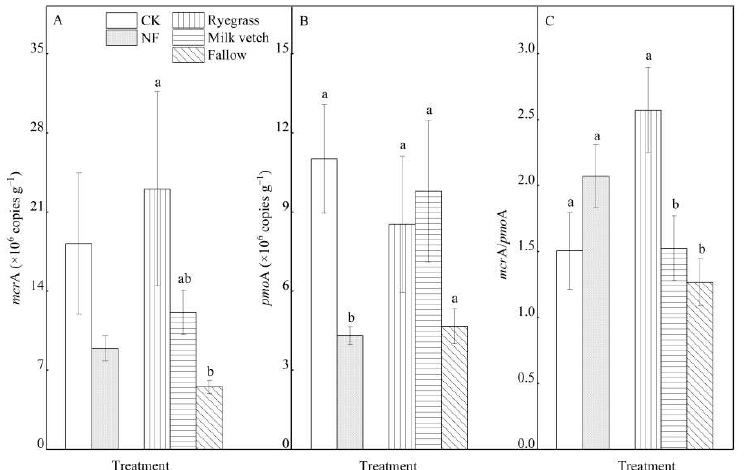
Figure 4. Copy numbers of soil mcr A ( A ), pmo A ( B ) genes and mcr A/ pmo A ratio ( C ) (means ± se) under fertilization and green manure amendment. Results were averaged across fertilization and green manure amendment treatment because there were no significant 2-way interactions. Different letter on the bars means the significant difference with confidence level set at 0.05.